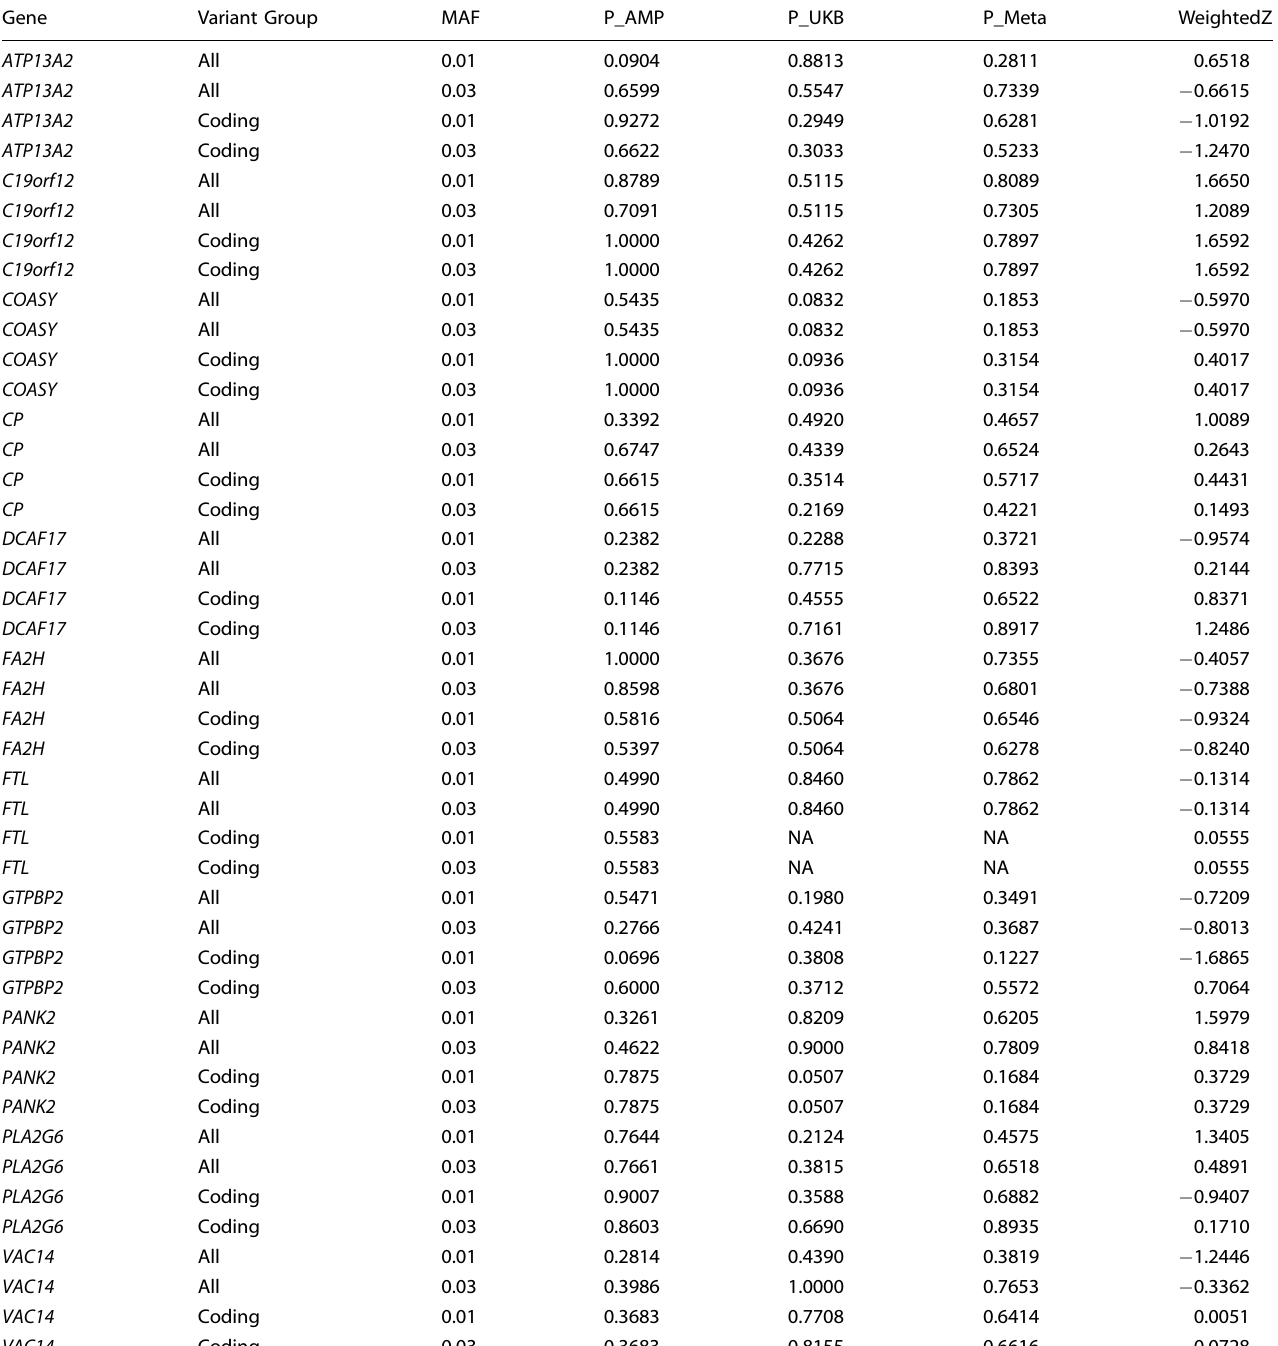
Table 3. Results of burden analysis at two minor allele frequencies for NBIA genes in